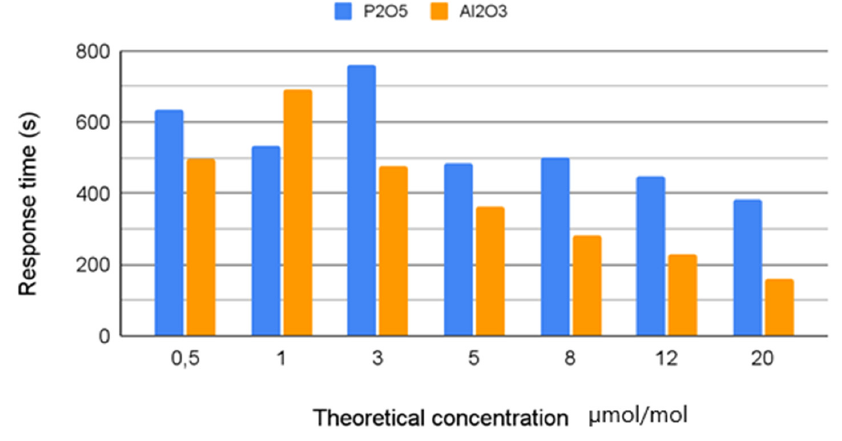
Figure 5. Comparative response time (T90) for two sensors measuring water concentrations (from 0.5 to 20 µmol/mol) in hydrogen.